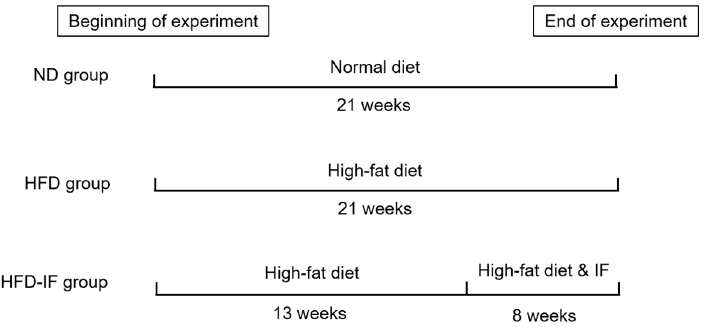
Figure 1. Schematic diagram of experimental design. Normal diet (ND) group: mice were fed ND for 21 weeks. High-fat diet (HFD) group: mice were fed HFD for 21 weeks. HFD-IF group: mice were fed HFD for 13 weeks and subjected to intermittent fasting (IF) for 24 h and fed HFD in the other day for 8 weeks.